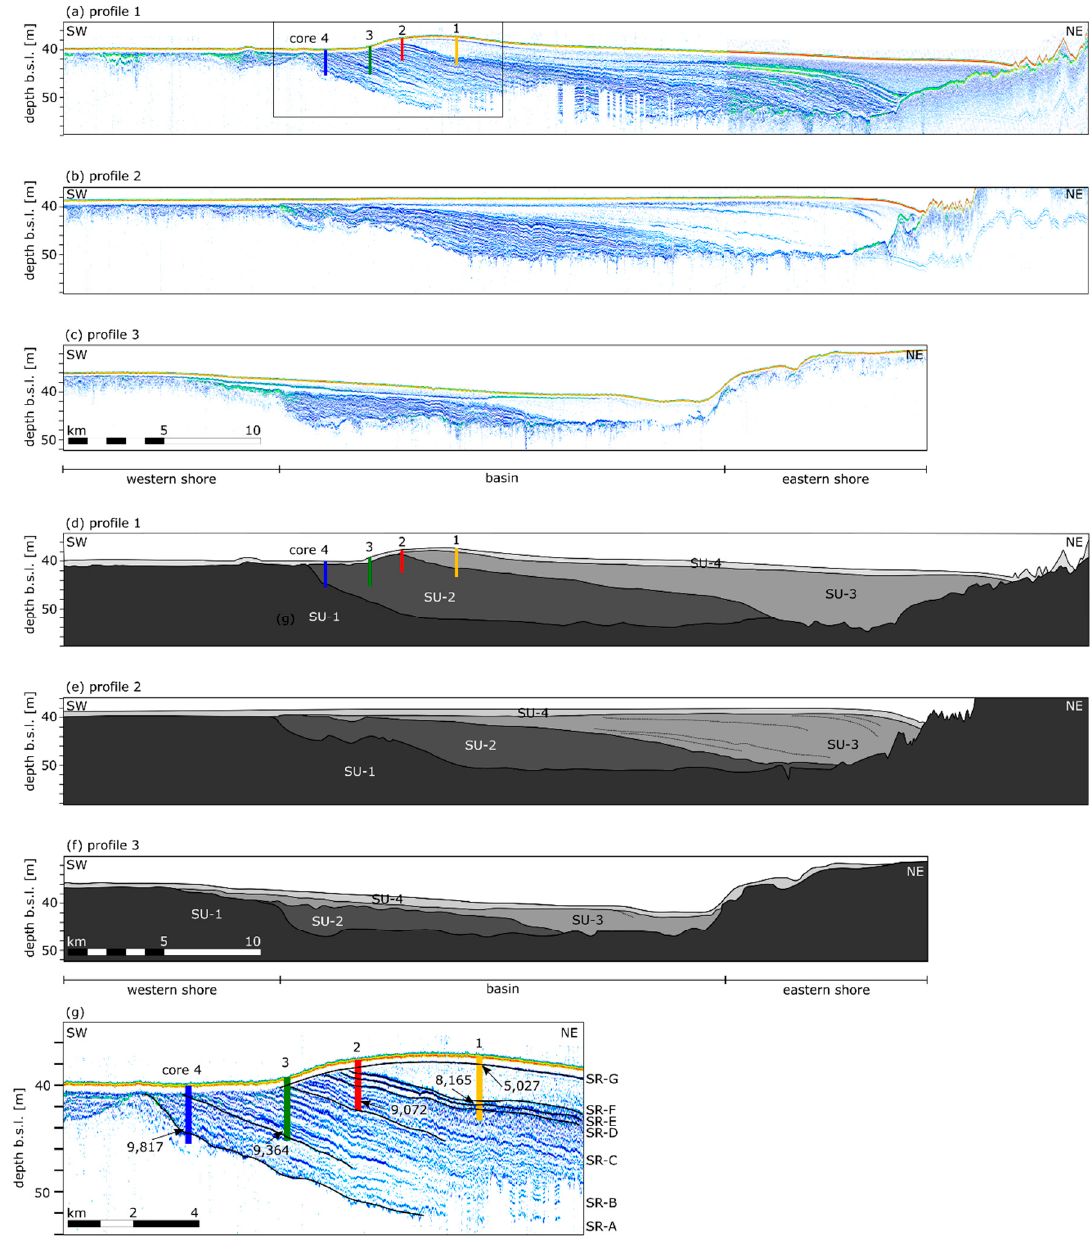
Figure 2. Cross profiles 1–3 of the PEV. For location see Figure 1. ( a – c ) Parametric sediment echo sounder profiles, ( d – f ) interpreted seismic units (SU), and ( g ) detail of profile 1 with some highlighted seismic reflectors (SR) and AMS 14 C age determination (cal. yr BP).